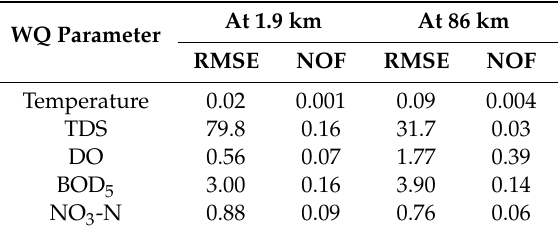
Table 5. The RMSE (mg / L) and NOF for water quality parameters of the El-Salam